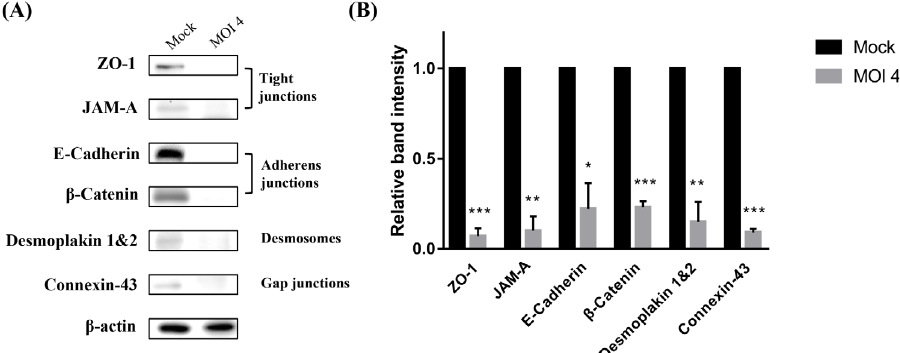
Figure 2. Reduction in cell junction protein expression in S-G cells caused by Trichomonas tenax . (A) Western blotting results of cell junctions (ZO-1, JAM-A, E-cadherin, b -catenin, desmoplakin 1 & 2, and connexin) expression levels of S-G cells stimulated by T. tenax at MOI 4 for 24 h. (B) Relative quanti fi cation of western blotting results was performed with ImageJ (* p (cid:3) 0.05, ** p (cid:3) 0.01, *** p (cid:3) 0.001, MOI: multiplicity of